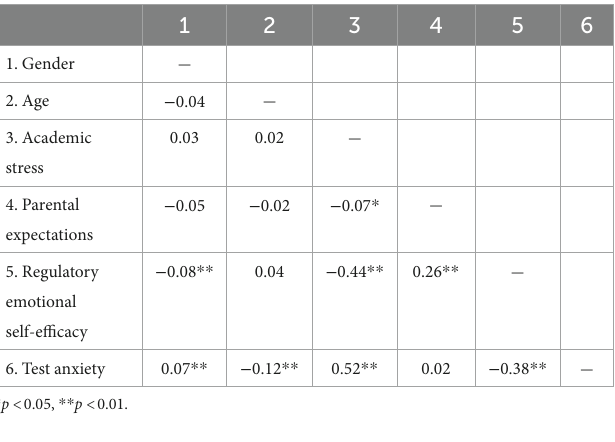
TABLE 2 Correlation between the